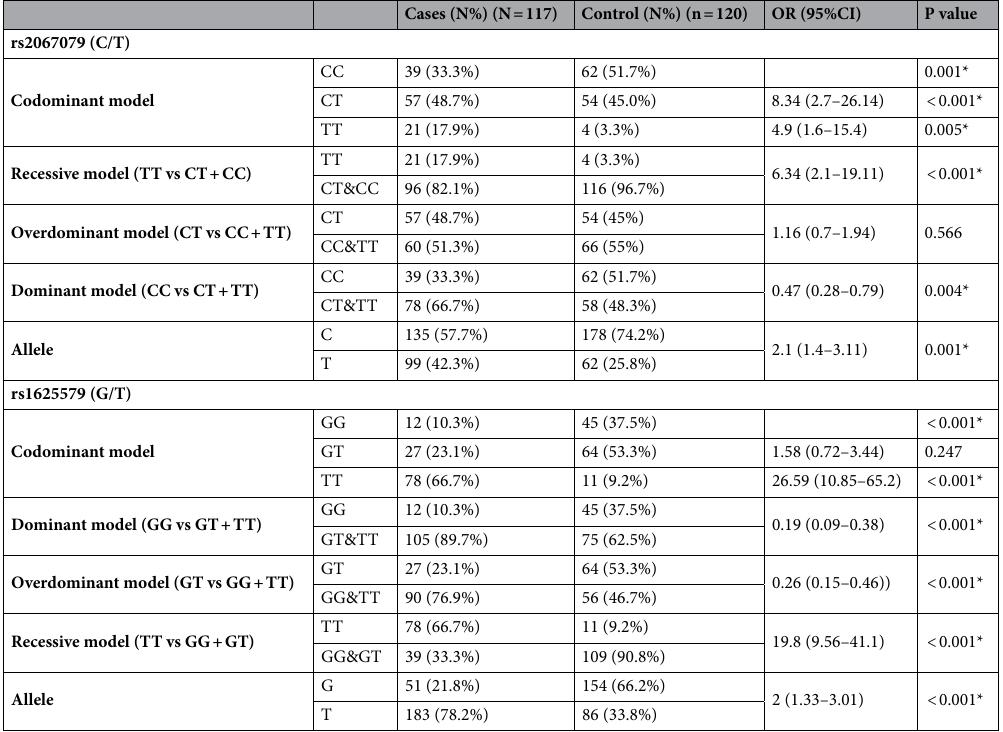
Cases (N%) (N = 117) Control (N%) (n = 120) OR